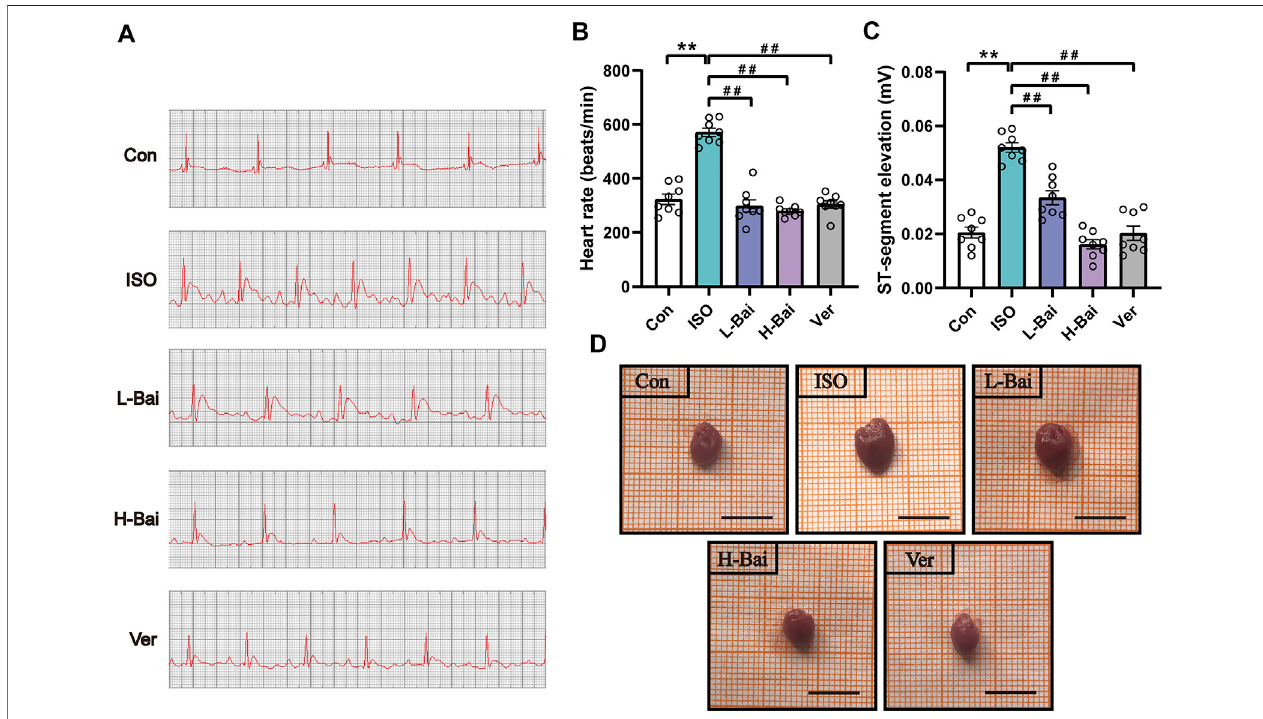
FIGURE 2 | (A) Representative electrocardiogram (ECG) tracings of each group in mice. (B) Statistical analysis of heart rate (C) ST segment in each group. (D) EffectsofBaionheartappearanceinmice.Scalebar=1 cm.Dataarethemeans±standarderrorofthemean(S.E.M.)forn=8. p < 0.01versuscontrol(Con); p < 0.01, p < 0.05 versus isoproterenol (ISO).